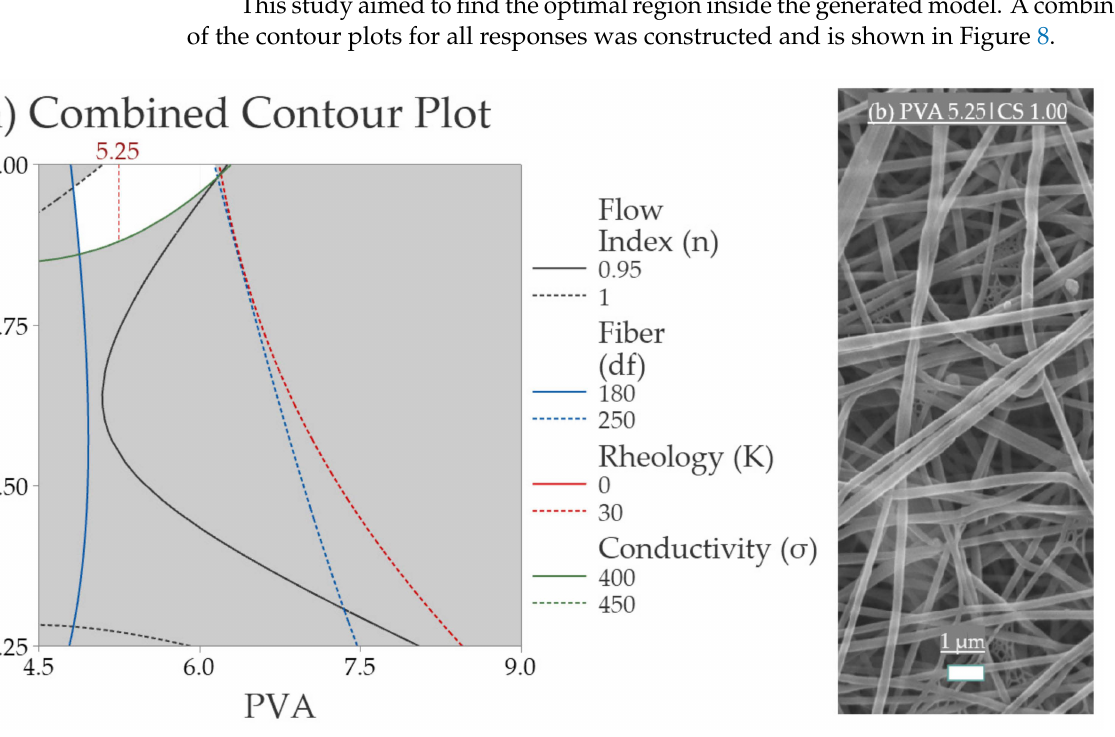
Figure 8. ( a ) Combined contour plots of the electrical conductivity, rheology consistency index, fiber diameter, and flow index, with defined margins for its properties. The white region shows the position of the validation assay; ( b ) SEM image of the sample with PVA 5.25%|CS 1.00%. The blank area in the graph represents the optimal region for all responses. To validate the model, a sample containing PVA 5.25|CS 1.00 was prepared and electrospun.